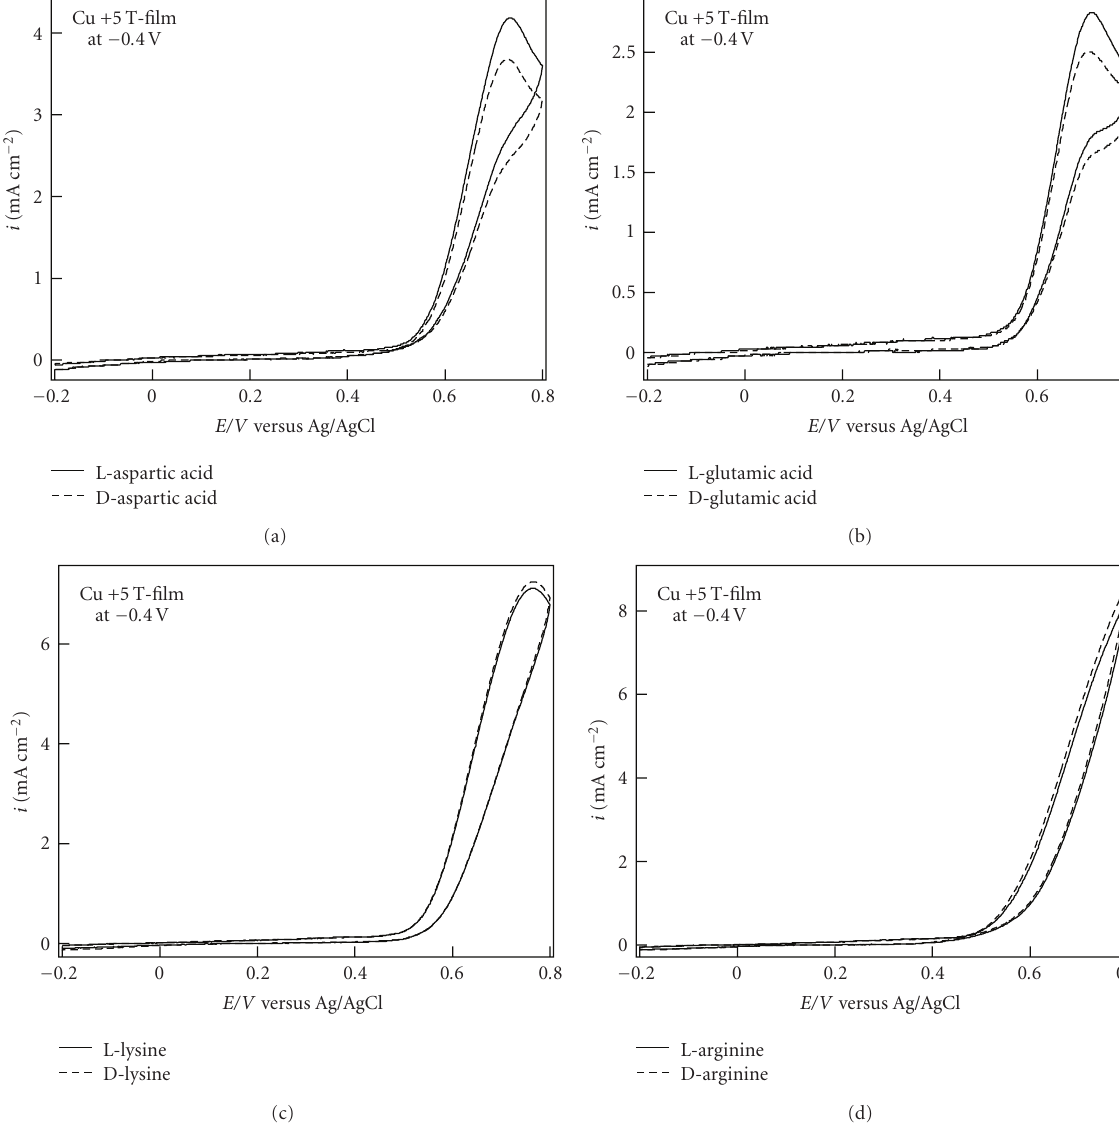
Figure 8: CVs of the enantiomers of (a) aspartic acid, (b) glutamic acid, (c) lysine, and (d) arginine on the Cu +5T-film electrodes in a 0.1MNaOH aqueous solution. The potential sweep rate was 10mVs − 1